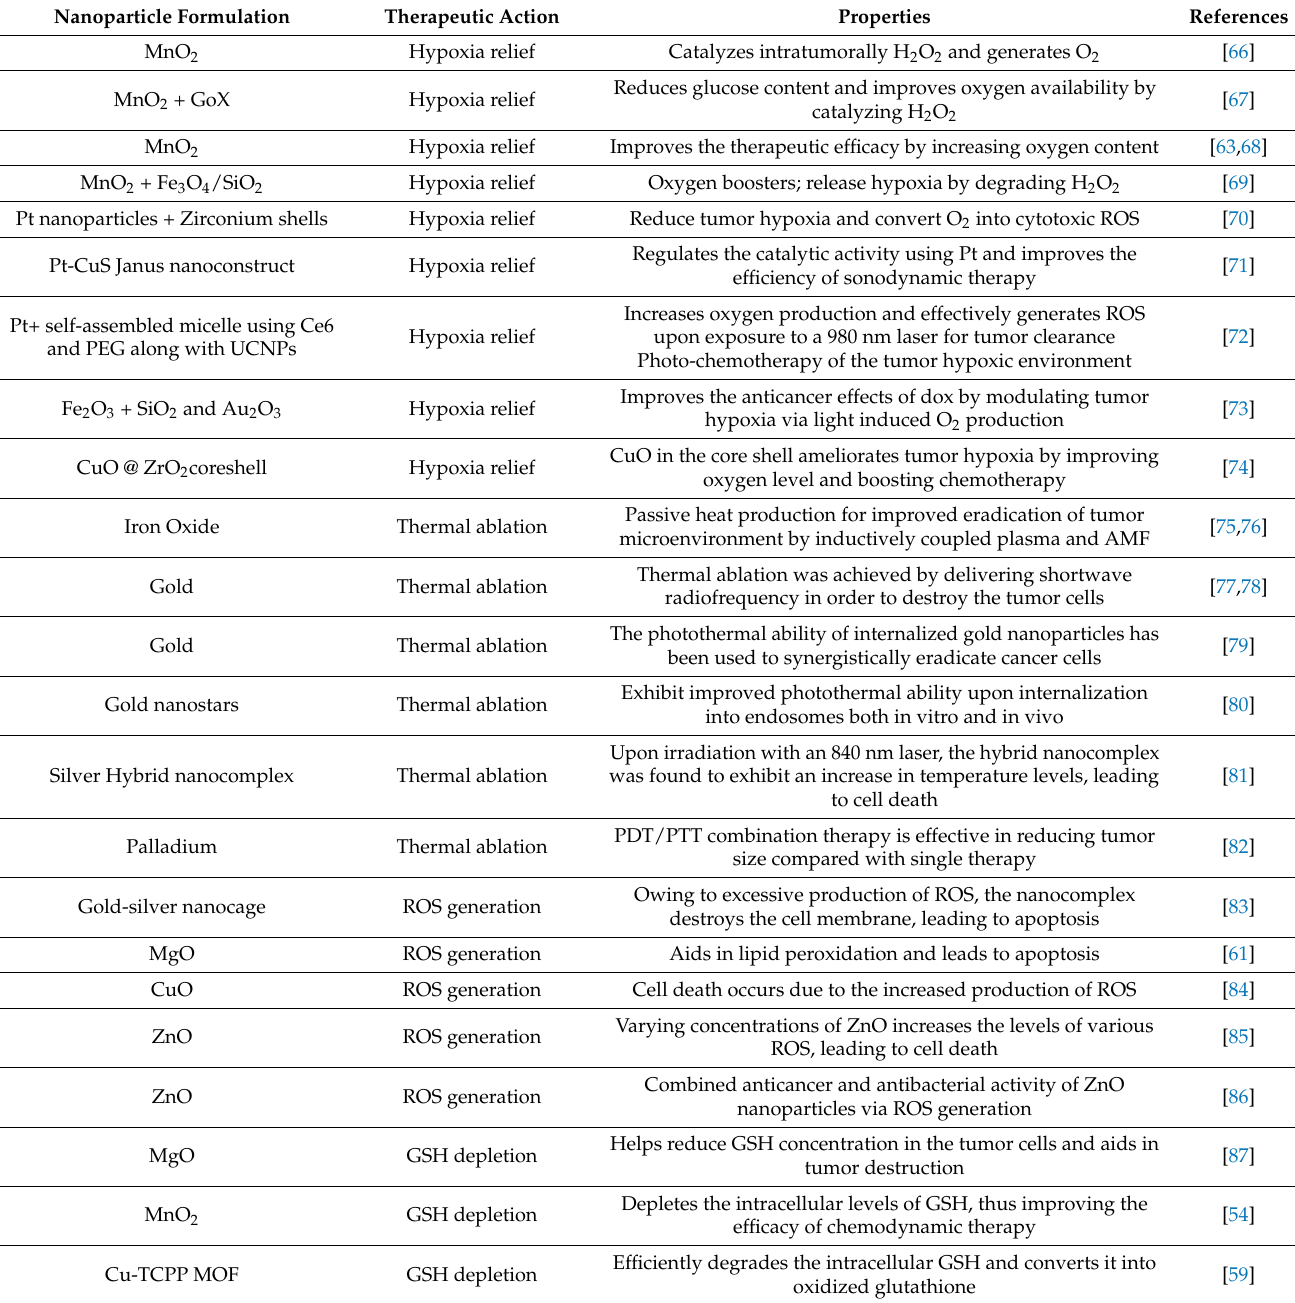
Table 1. Role of MNPs in TME